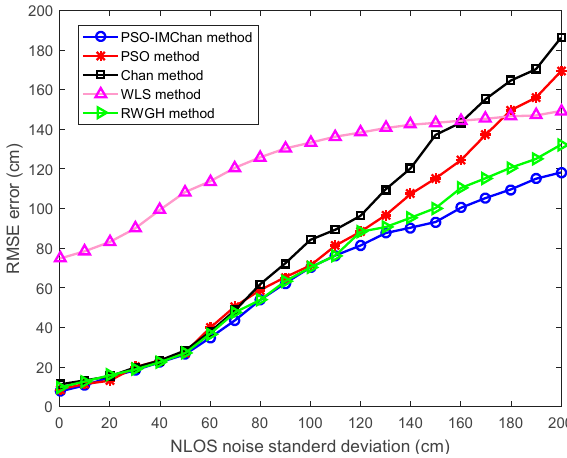
Figure 6. The performance of different methods under different NLOS noise standard deviation.